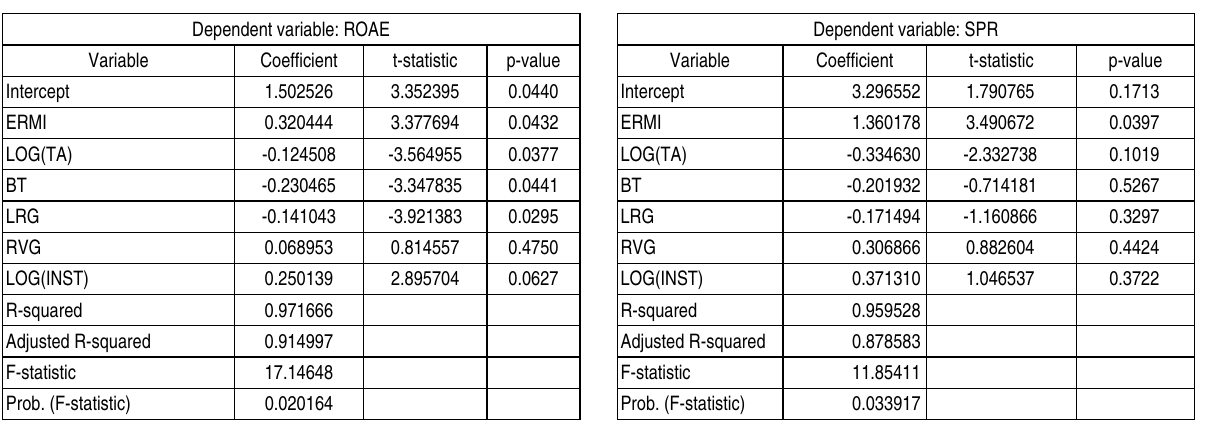
Table 4 . OLS - regression model